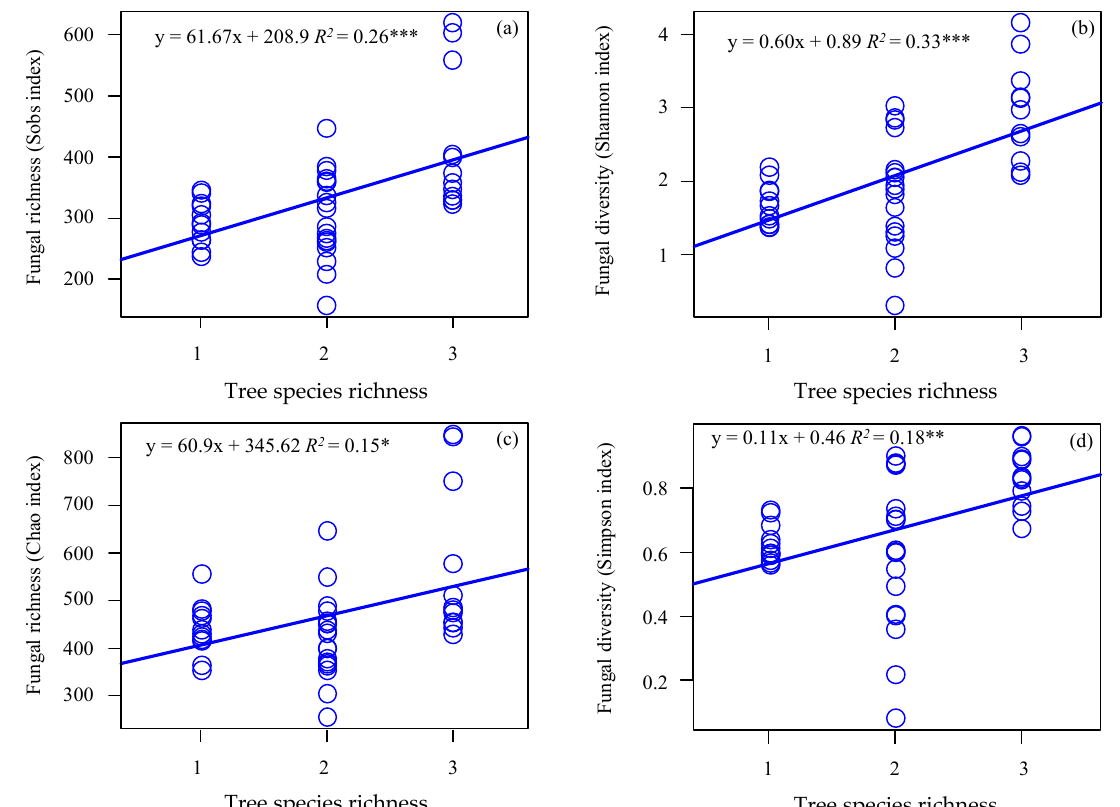
Figure 5. Correlation between soil fungal diversity and richness and tree species richness in tree clusters with varying tree species richness of one, two, and three tree species combinations in subtropical evergreen broad-leaved forest. Soil fungal richness: ( a ) Sobs index, ( c ) Chao index. Soil fungal diversity: ( b ) Shannon index, ( d ) Simpson index. * p < 0.05, ** p < 0.01, *** p < 0.001.